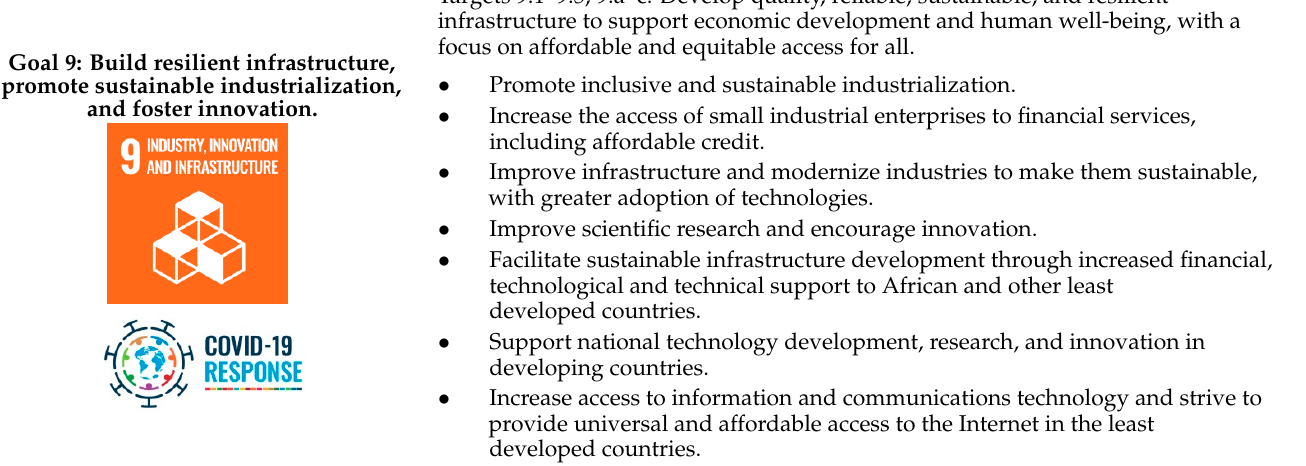
Table 5. Impact of the Sustainable Development Goals on IoT applications for improving health and the environment. SDGs Targets Goals and Application to IoT